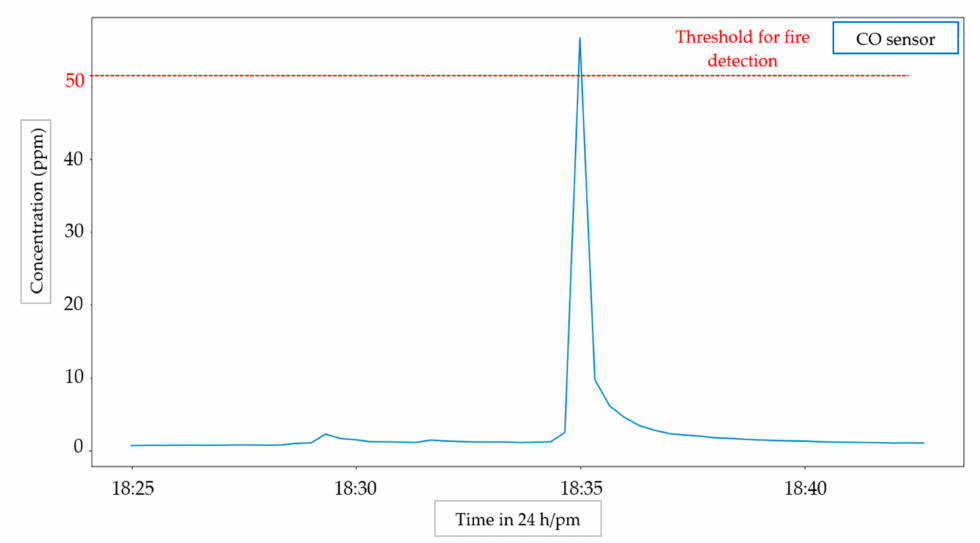
Figure 10. Concentration values for the CO sensor before the event, during the event (time period from 18:34:00 to 18:35:50 24 h/pm), and after the event. The red represents the threshold associated with fire detection.